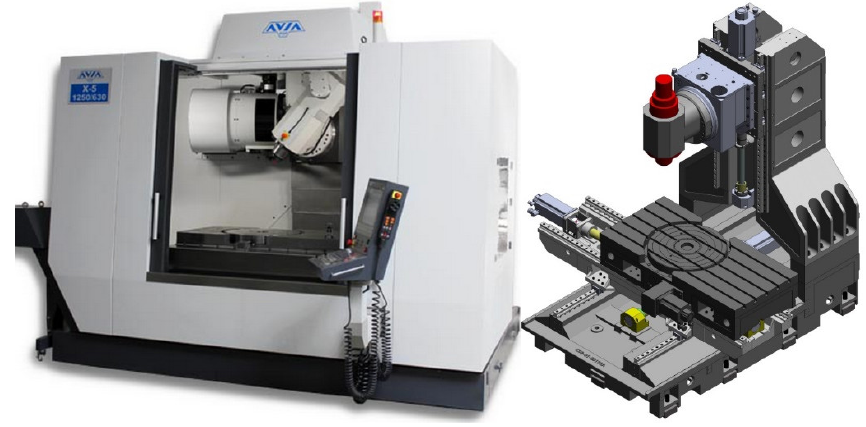
Figure 10. AVIA X-5 machining centre and its SolidWorks model.